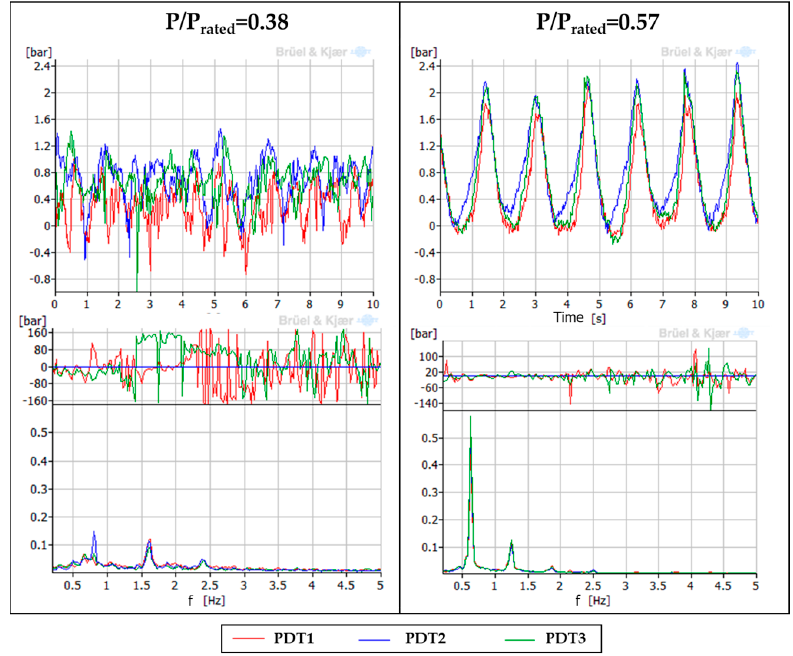
Figure 11. Time signal and phase-assigned spectrum of three pressure sensors located in the draft tube (PDT1-2-3) for two different operating points.